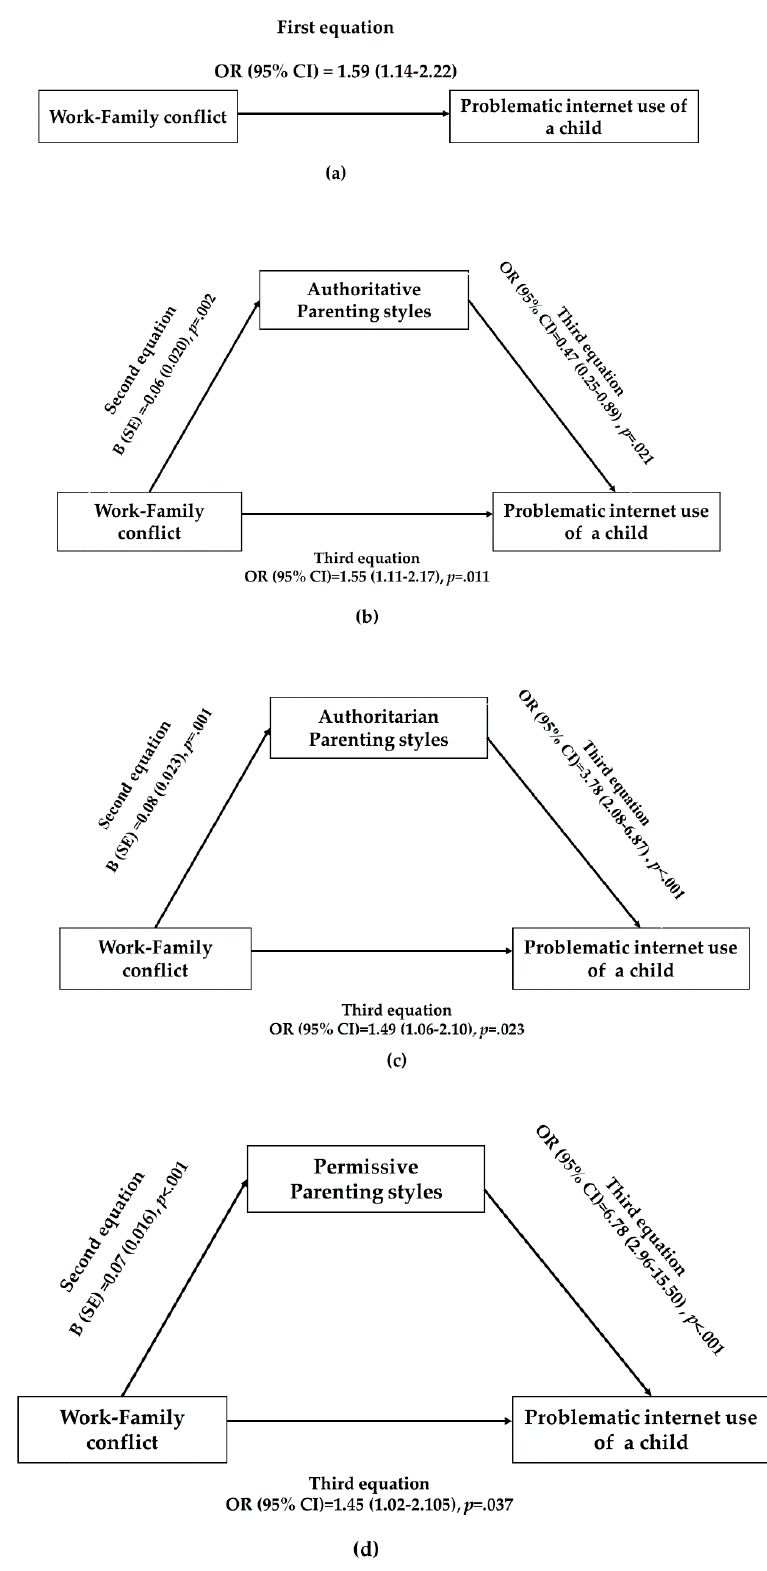
Figure 2. Testing for a mediating effect of parenting styles on the association between WFC and the PIU of a child using logistic regression analysis; ( a ) Direct pathway from WFC to the PIU of a child; ( b ) Indirect pathway from WFC to the PIU of a child via authoritative parenting style; ( c ) Indirect pathway from WFC to the PIU of a child via authoritarian parenting style ( d ) Indirect pathway via permissive parenting